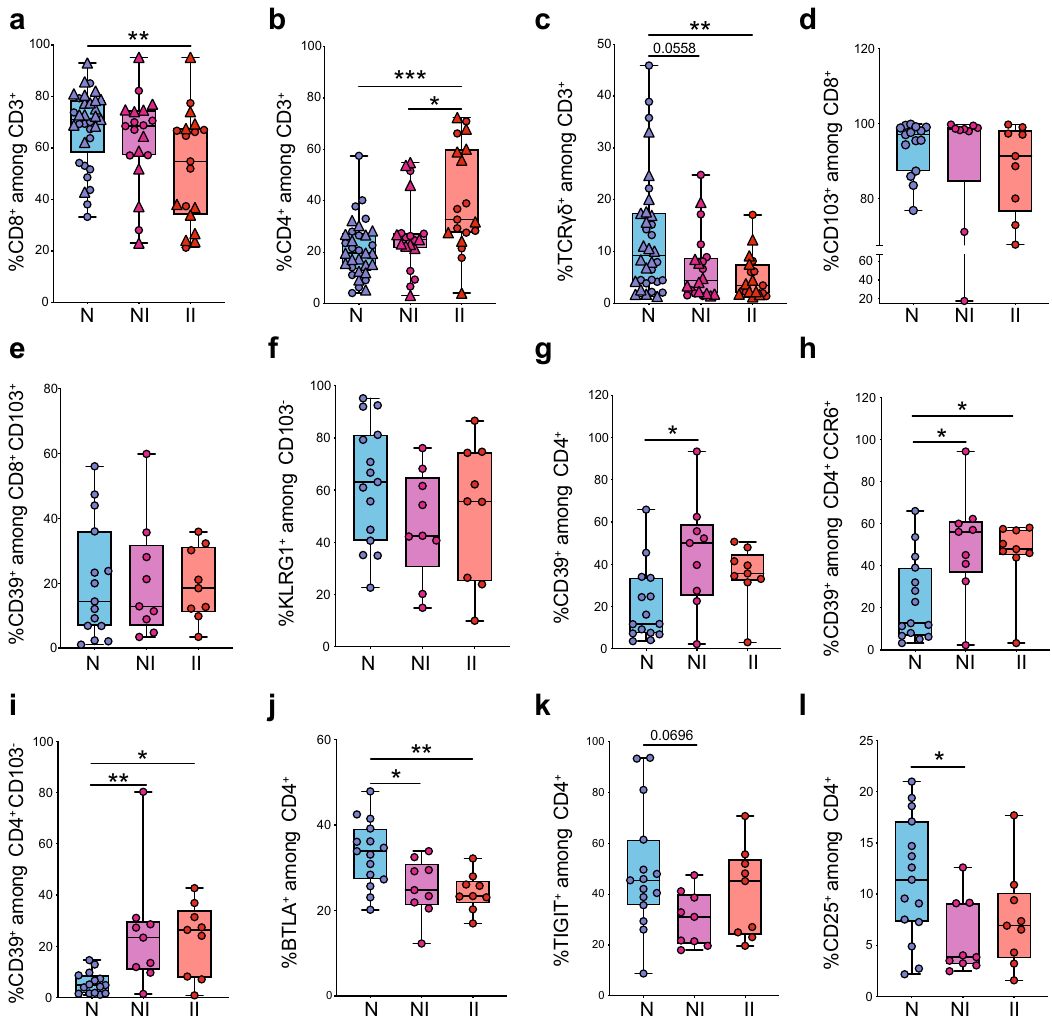
Fig. 3 Quanti fi cation of IEL CD8 + T cell, CD4 + T cell subsets and γδ T cells by fl ow cytometry. a Percentages of IEL CD8 + among CD3 + T cells in terminal ileum of controls and CD patients. b Percentages of IEL CD4 + among CD3 + T cells in terminal ileum of controls and CD patients. c Percentages of IEL TCR γδ + among CD3 + T cells in terminal ileum of controls and CD patients. a , b Controls ( N ), n = 33 (15 frozen, 18 fresh); CD, non-in fl amed site (NI), n = 19 (9 frozen, 10 fresh); CD, in fl amed site (II), n = 19 (9 frozen, 10 fresh). c Controls ( N ), n = 34 (16 frozen, 18 fresh); CD, non-in fl amed site (NI), n = 20 (10 frozen, 10 fresh); CD, in fl amed site (II), n = 19 (9 frozen, 10 fresh). Circles and triangles on the boxplots show data collected for each individual donor. Circles = frozen samples. Triangles = fresh samples. Data were median and interquartile range. d – f Quanti fi cation of total CD8 + T RM ( d ), CD39 + T RM ( e